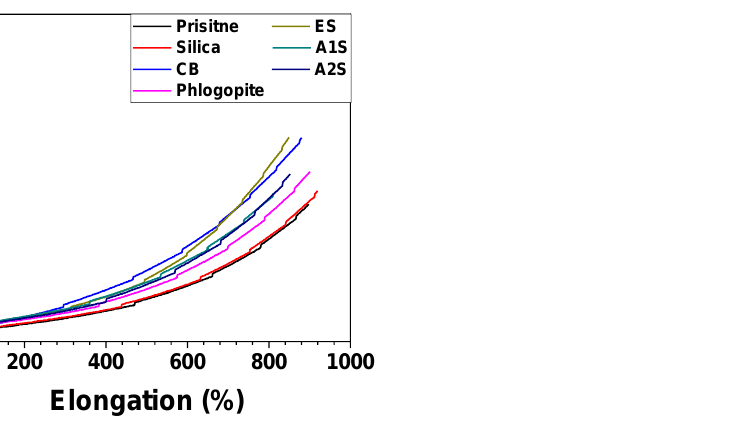
Figure 3. Tensile properties of NR/EPDM blend and composites with different fillers and phlogopite functionalization types (A1S, A2S, and ES): ( a ) Tensile strength, ( b ) modulus, ( c ) elongation at break, and ( d ) toughness, ( e ) stress – strain plots.